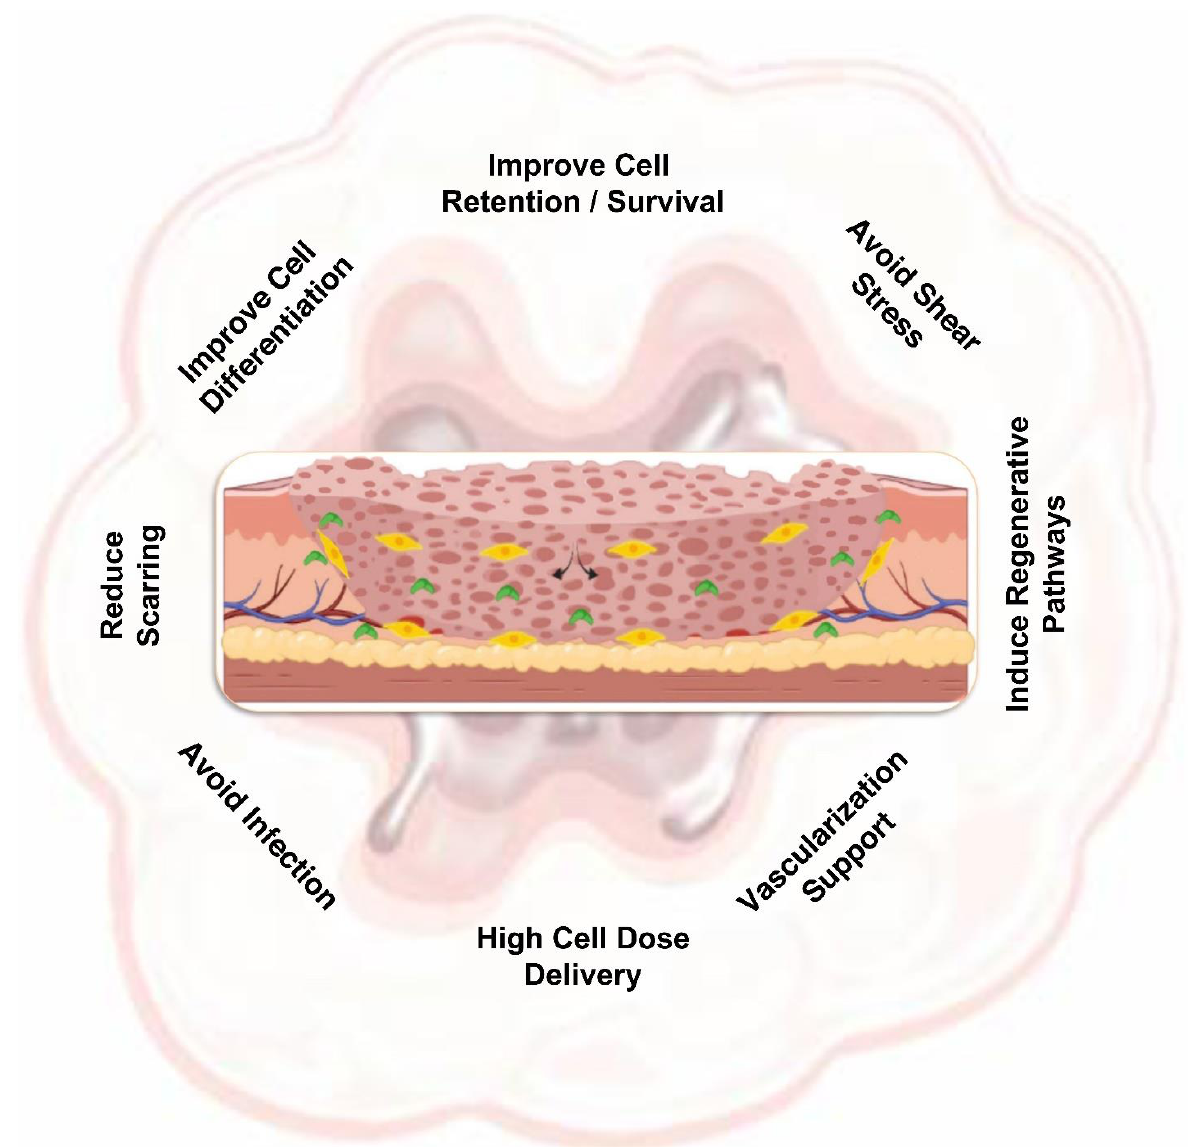
Figure 3. A schematic representation of the contribution of biofabricated matrices to cell therapy in cutaneous wounds. By virtue of their role as a supportive carrier, biofabricated constructs could carry huge amounts of cells and protect them in the harsh wound environment. Additionally, they incorporate bioactive features of various molecules to fight infection, induce vascularization and regeneration. Accordingly, wounds can heal without severe scars. The two arrows indicate the re- lease of pre-loaded bioactive molecules from the